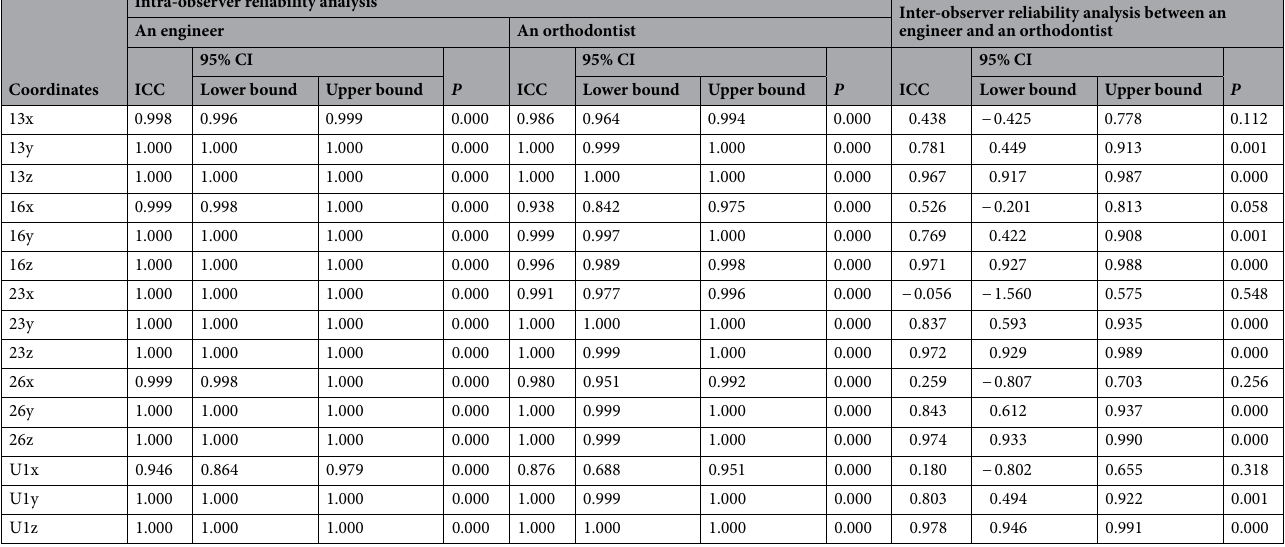
Table 1. Reliability of x, y, and z coordinates of each tooth during immerging of digital maxillary cast images and facial CBCTs. ICC intraclass correlation coefficients, 13/23 the cusp of maxillary right/left canine, 16/26 the mesio-buccal cusp of maxillary right/left first molar, U1 the contact point between the maxillary central incisors, CI confidence interval; ICC > 0.8/0.6/0.4/0.2 or ≤ 0.2 represent almost perfect, substantial, moderate, mediocre, or low strength of agreement,